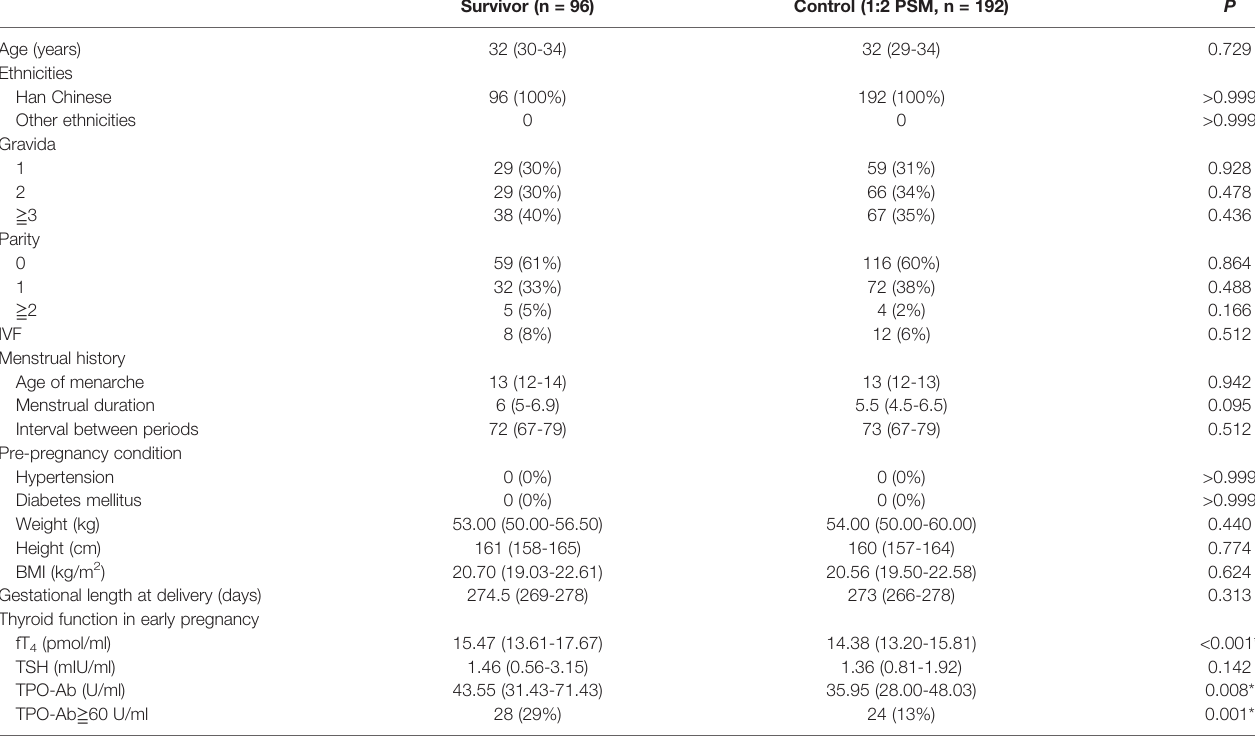
TABLE 2 | The baseline and thyroid function information of included